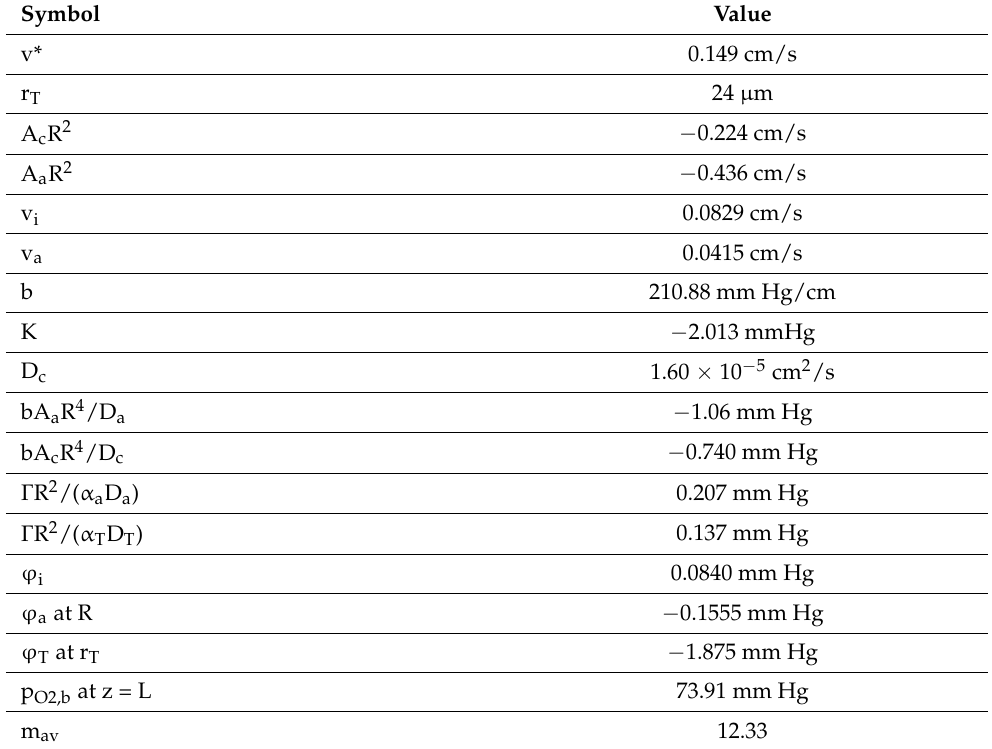
Table 2. Results for oxygen transport using Table 1 for µ c / µ a = 1.947 and σ = 0.9. (HD =